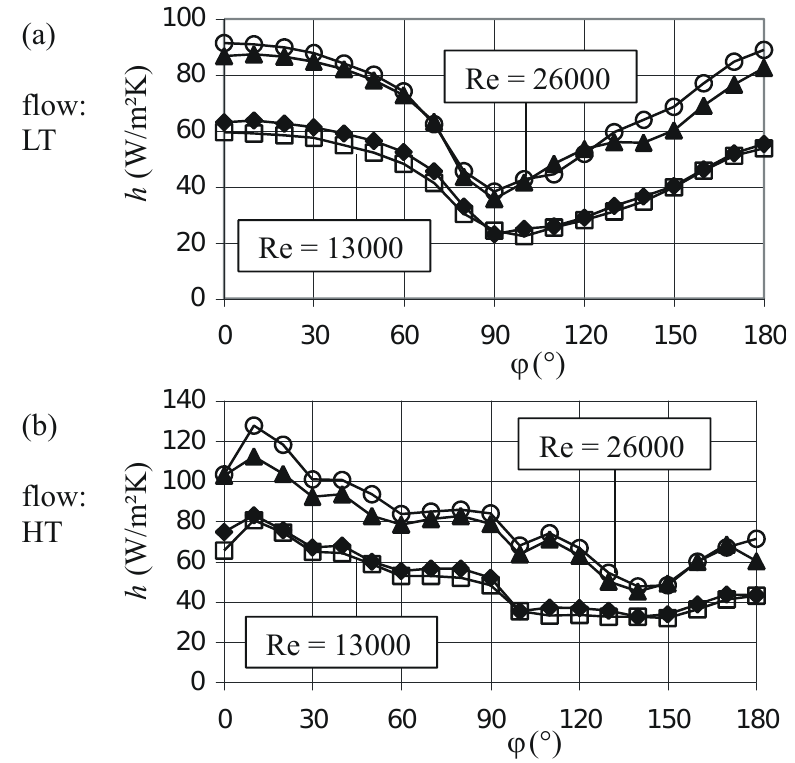
Figure 14. Comparative data and passively measured heat transfer coefficients. (a) black symbols ... comparative data. (b) open symbols ... passively measured